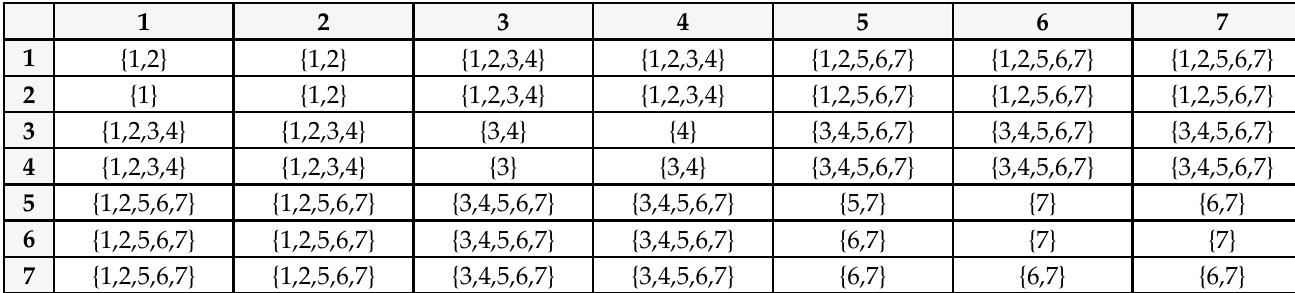
Table 19. Left almost-hypergroup.